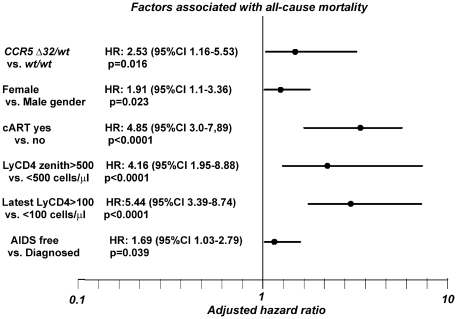
Multivariate Cox regression model of factors modifying 15 year mortality among HIV infected patients (favorable versus unfavorable parameter).Dots represent adjusted hazard ratio (HR) for the unfavorable parameters, lines represent confidence intervals for the HR.